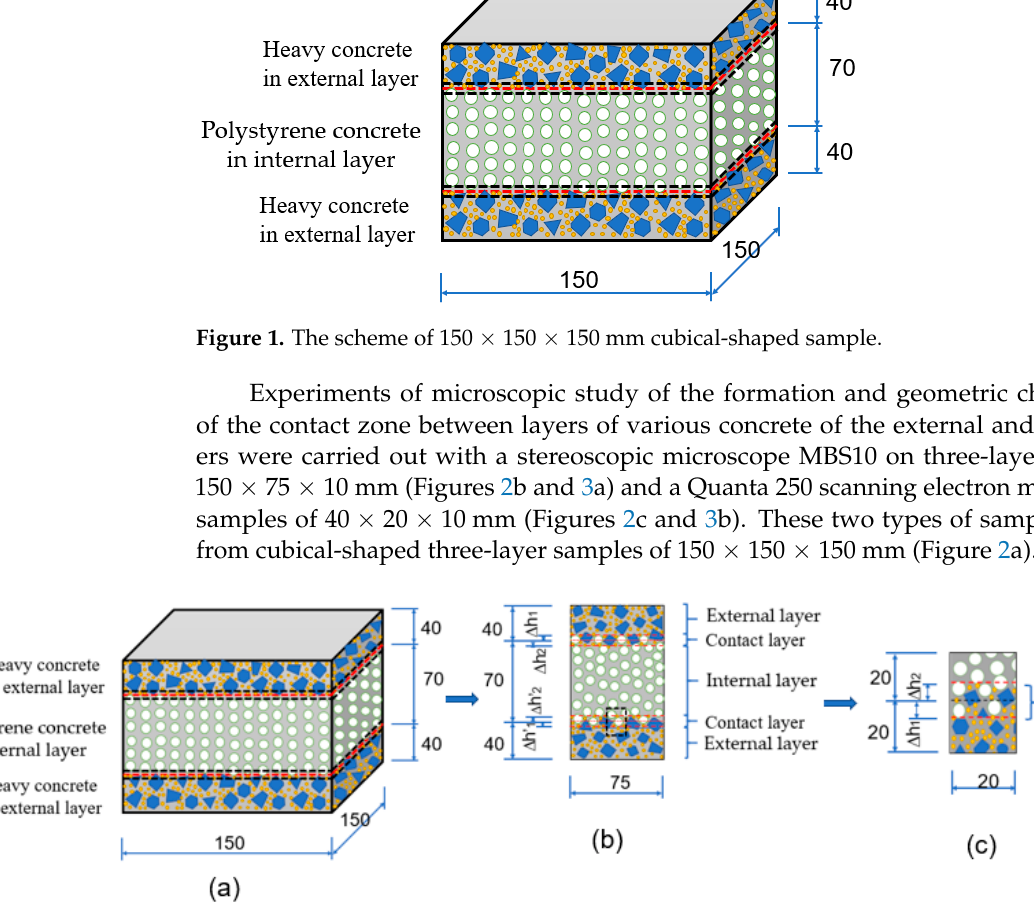
Figure 2. The samples for experiments of the formation and geometric characteristics of the contact interlayer between layers: ( a ) The cubic three-layer samples 150 × 150 × 150 mm; ( b ) The samples 150 × 75 × 10 mm for experiment’s stereoscopic microscope MBS10; ( c ) The samples 40 × 20 × 10 mm for experiment’s scanning electron microscope Quanta